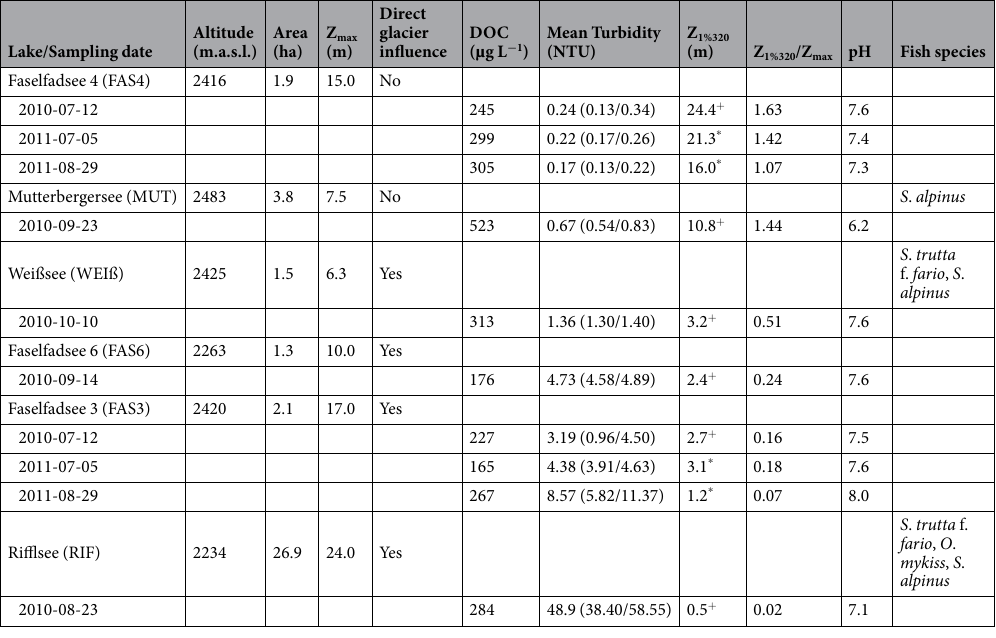
Table 1. Main characteristics of the study lakes including the day of sampling, altitude, lake area, maximum lake depth (z max ), water optical properties (mean dissolved organic carbon content (DOC), mean turbidity (nephelometric turbidity units, NTU; min/max), depth of 1% of surface irradiance for 320 nm UV (Z 1%320 ), and fraction of the water column to which 1% of the surface irradiance at 320 nm penetrated [Z 1%320 /Z max ]) on the day of sampling, mean pH, and fish species present in the lakes. ( S . alpinus : Salvelinus alpinus ; S . trutta f. fario : Salmo trutta forma fario ; O . mykiss : Oncorhynchus mykiss ). Z 1%320 derived from PUV-501B depth profiles ( * ) or CDOM ( + ),